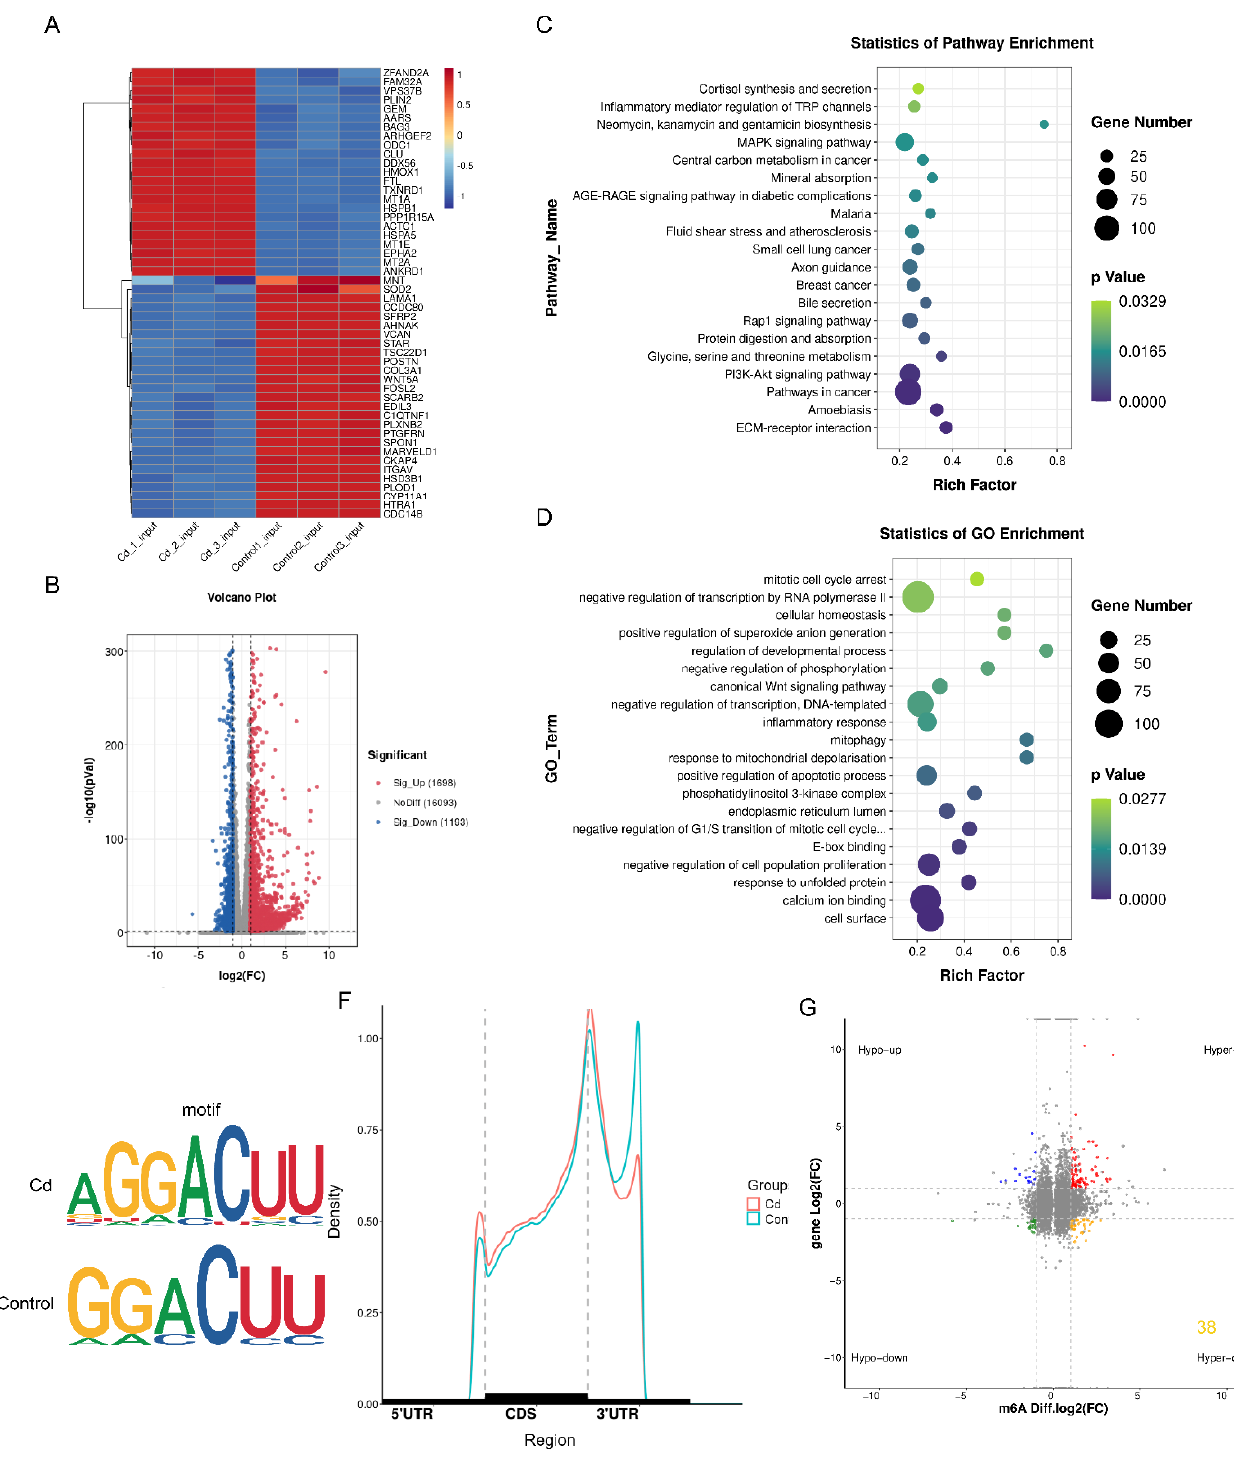
Figure 4. Transcriptome and MeRIP sequencing of the control and Cd groups. ( A ) Heat map results revealed differential transcript levels after Cd treatment. ( B ) Volcano map showed the differentially expressed mRNAs in the control and Cd groups. ( C , D ) GO and KEGG analyses results revealed the enrichment of differential genes in the control and Cd groups. ( E ) The HOMER motif analysis results revealed the m 6 A motif in granulosa cells. ( F ) Density distribution of m 6 A enrichment across mRNA transcriptome in granulosa cells. ( G ) Distribution of peaks with significant differences in the RNA expression and m 6 A modification level in the control and Cd groups.